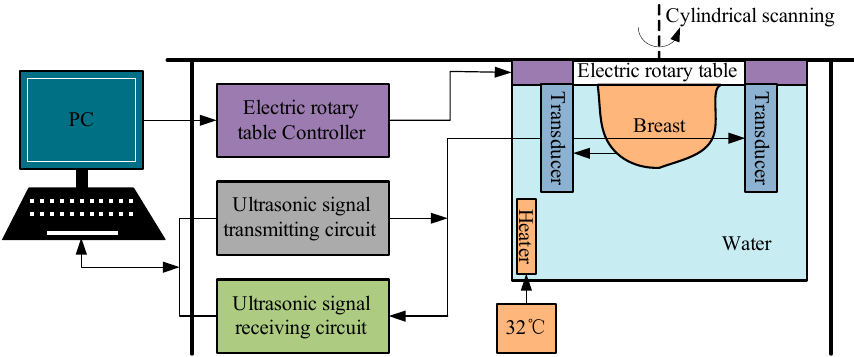
Figure 1. Schematic diagram of the experimental setup.